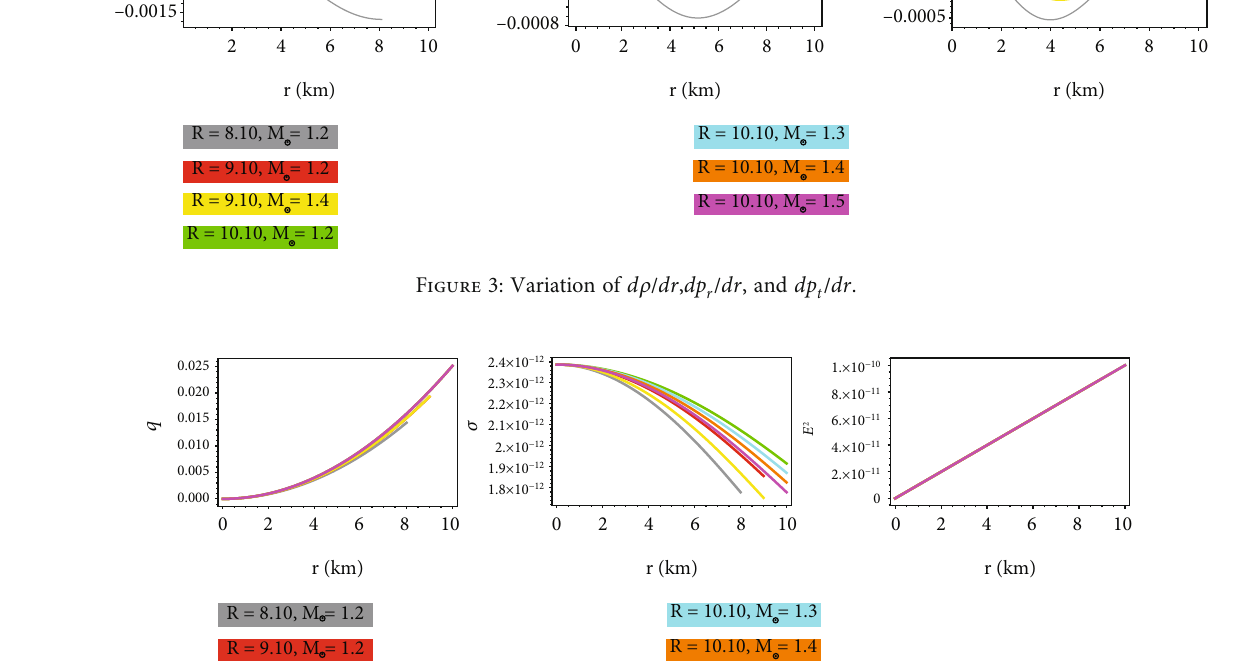
Figure 4: Variation of q , σ , and E 2